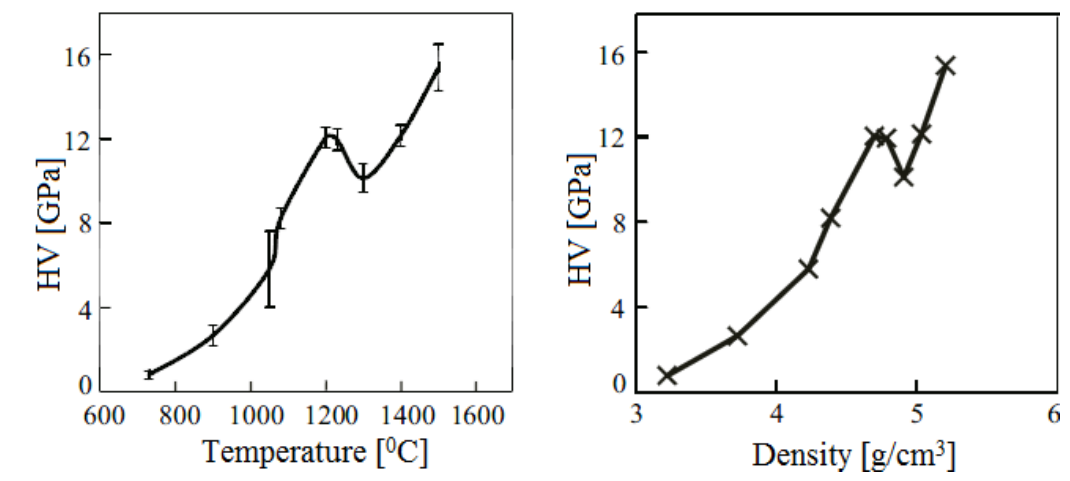
Figure 39. Vickers microhardness of sintered TiN